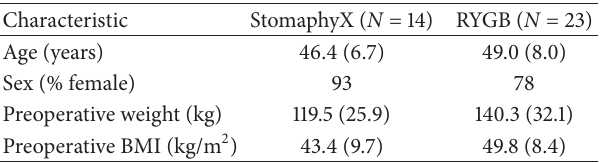
Table 1: Patient characteristics of failed VBG patients following StomaphyX or RYGB ( 𝑁 = 37 ).